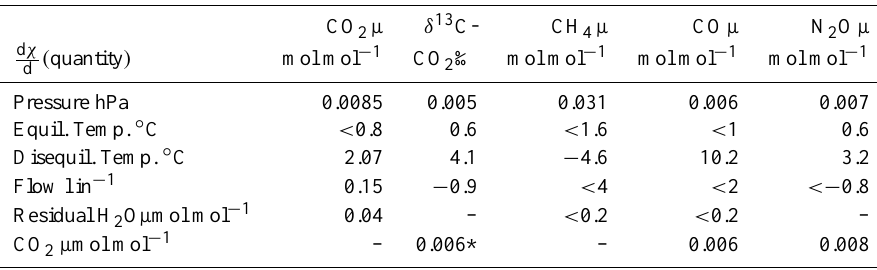
Table 2. Linear sensitivities d χ /d(quantity) of trace gas measurements to quantities pressure, temperature, flow and other trace gases in the sample. From Hammer et al. (2012).